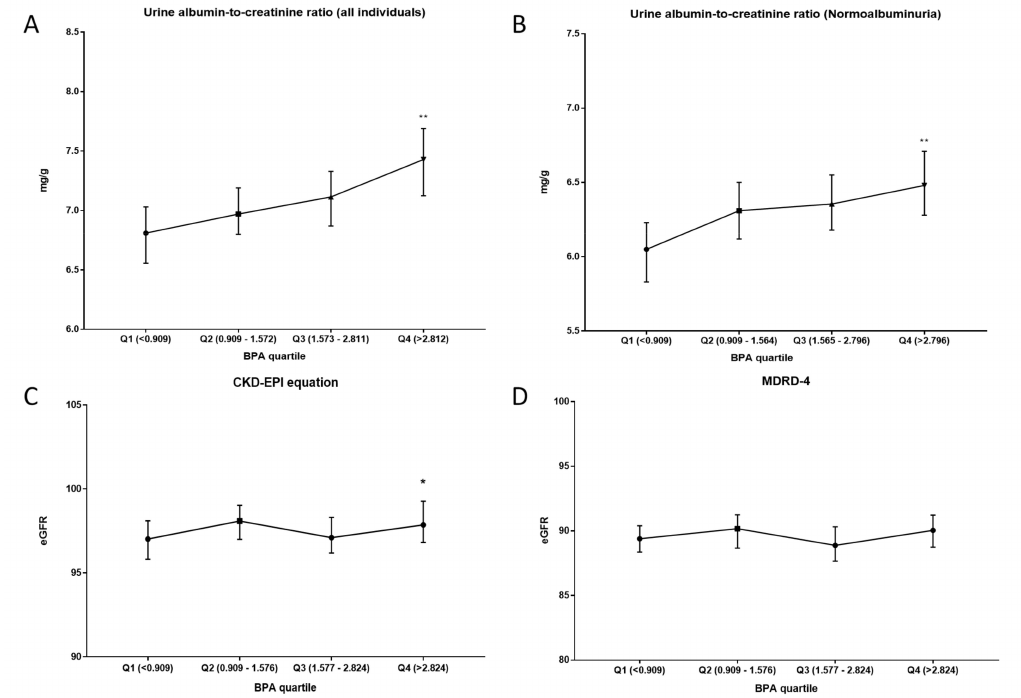
Figure 9. Schematic representation of the results obtained in the parameters related to renal function according to the BPA quartile. ( A ) Urine albumin-to-creatinine ratio (mg/g) in all individuals of the cohort. ( B ) Urine albumin-to-creatinine ratio (mg/g) only in normoalbuminuric individuals (<30 mg/g). ( C ) CKD-EPI equation for eGFR. ( D ) MDRD-4 equation for eGFR. All results were expressed as median (95% CI). Kruskal–Wallis test followed by Dunn ´ s multiple comparisons test or Mann–Whitney test was performed. * p -value < 0.05; ** p -value <